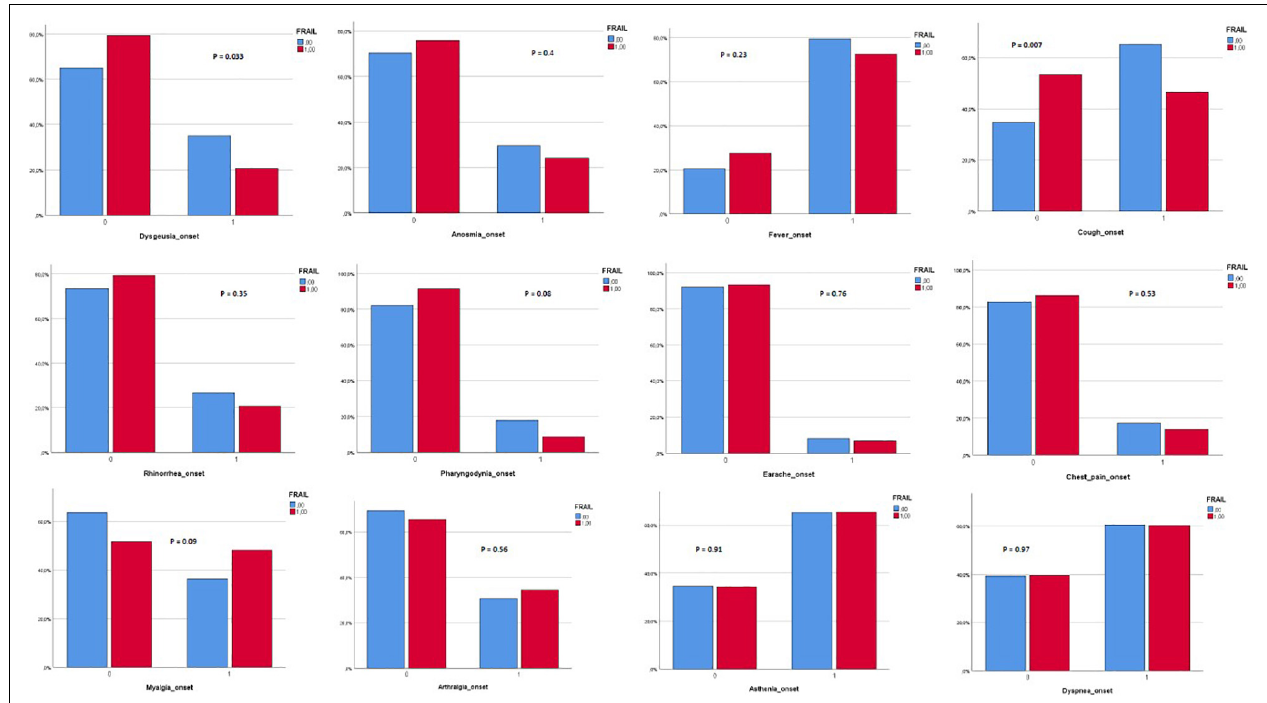
FIGURE 2 | Length of hospital stay in frail and robust patients. Robust patients: Median: 14 days; 25 ◦ percentile: 10 days; 75 ◦ percentile: 23 days. Frail patients: Median: 18.5 days; 25 ◦ percentile: 11 days; 75 ◦ percentile: 30 days.